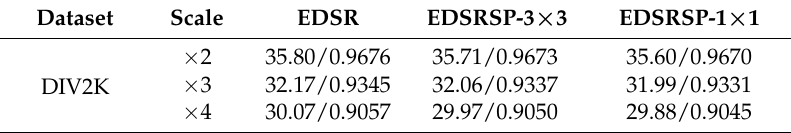
Table 2. Performance comparison between architectures on the DIV2K validation set (PSNR (dB)/SSIM).